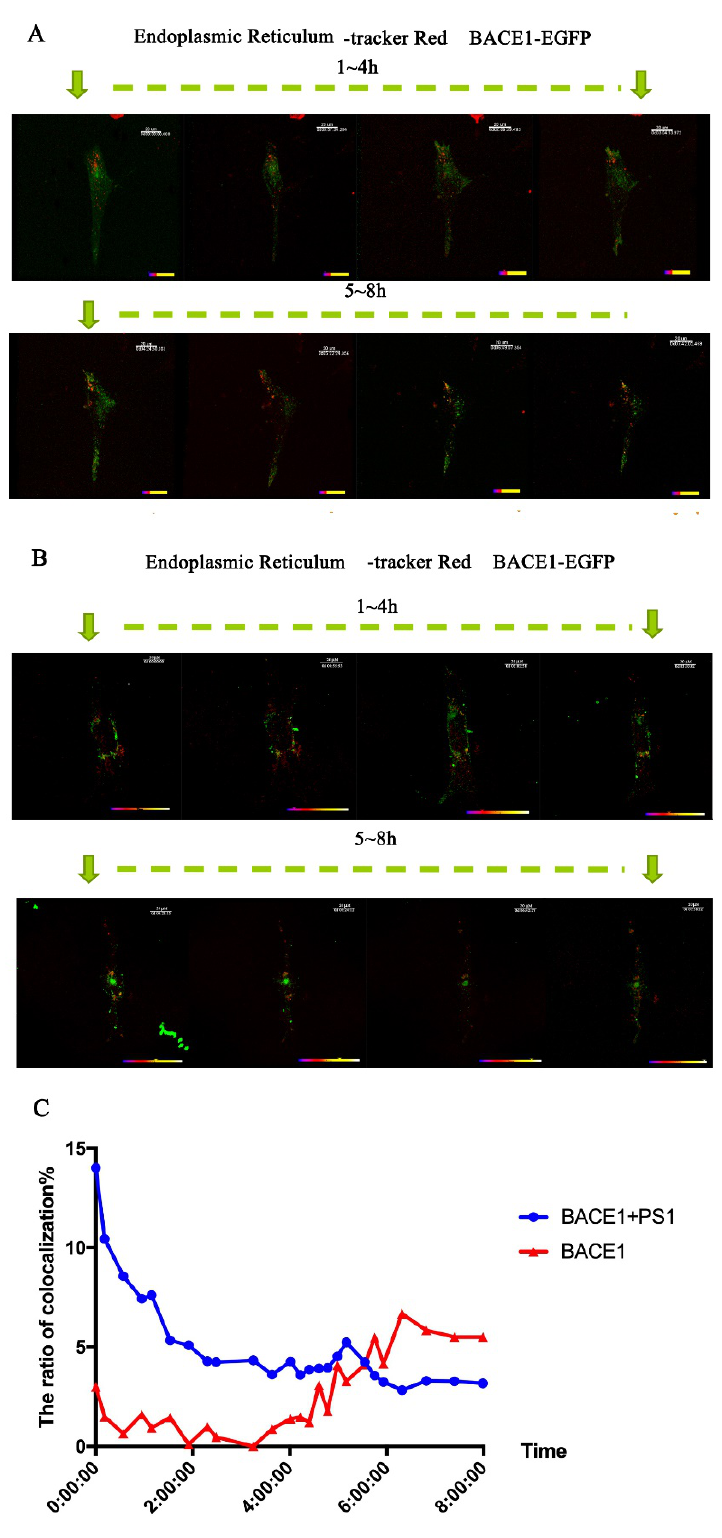
Figure 5. Time-lapse imaging of BACE1 and the ER tracker with or without PS1. ( A ) The distribution of BACE1-EGFP without PS1. ( B ) The distribution of BACE1-EGFP with PS1. ( C ) Quantitative analysis of the colocalization of BACE1-EGFP and the ER tracker with and without PS1.